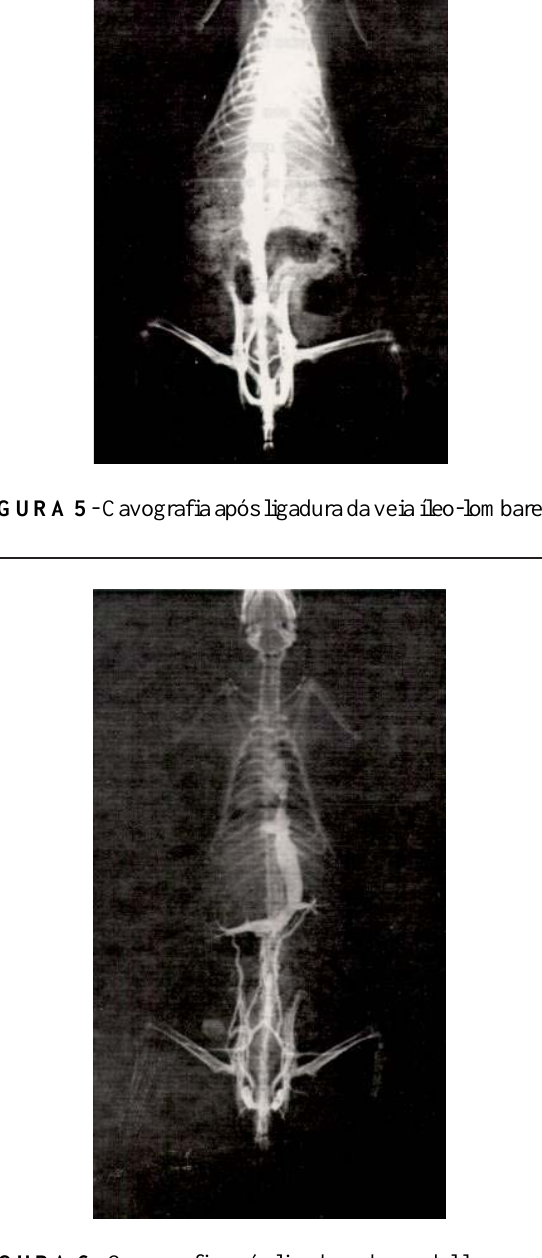
FIGURA 6 - Cavografia após ligadura da caudal logo cava acima logo das veias veia